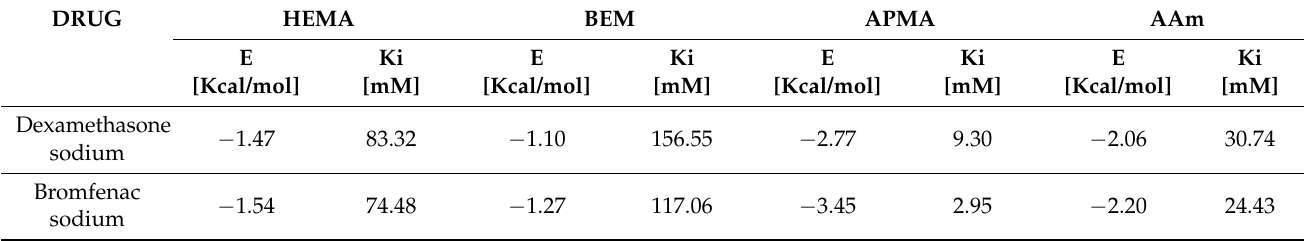
Table 2. Free energy of interaction (E) and dissociation constant (Ki) of bromfenac sodium and dexamethasone sodium with HEMA, BEM, APMA and AAm